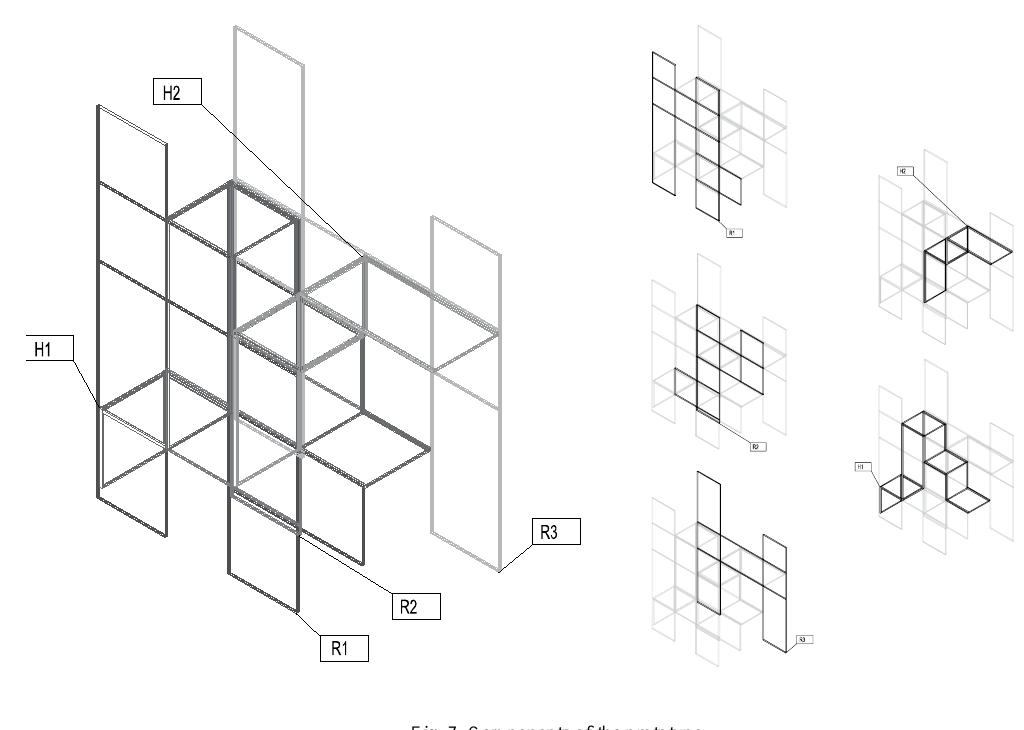
Fig. 7: Components of the prototype